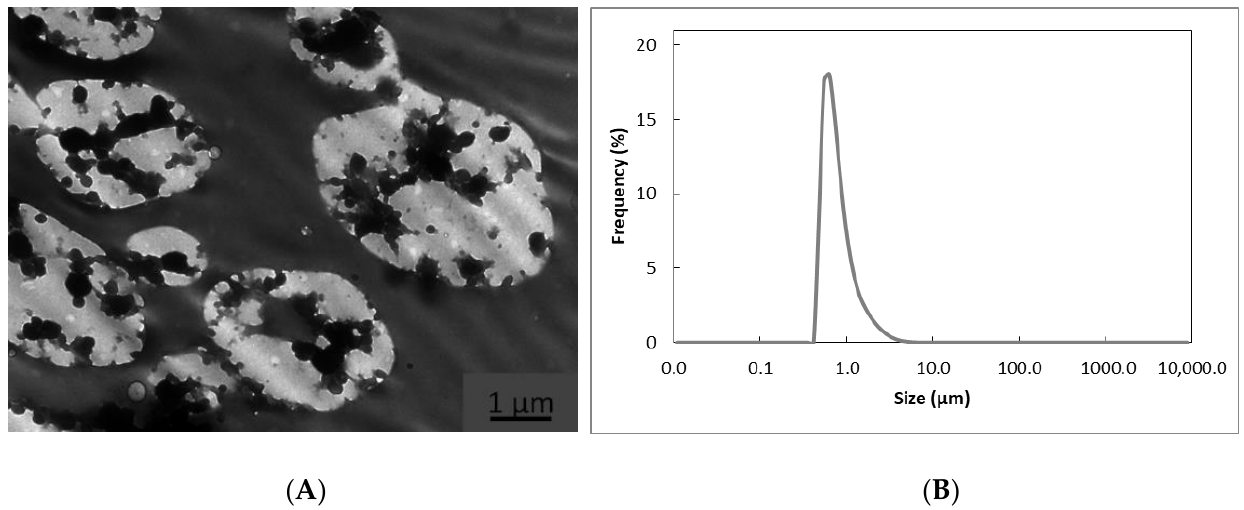
Figure 2. ( A ) TEM image of the EPA-rich oil-loaded WPC capsules. ( B ) Emulsion droplet size distribution obtained by laser diffraction Figure 2. A ) TEM image of the EPA-rich oil-loaded WPC capsules. B ) Emulsion droplet size distribution obtained by laser diffraction analysis.